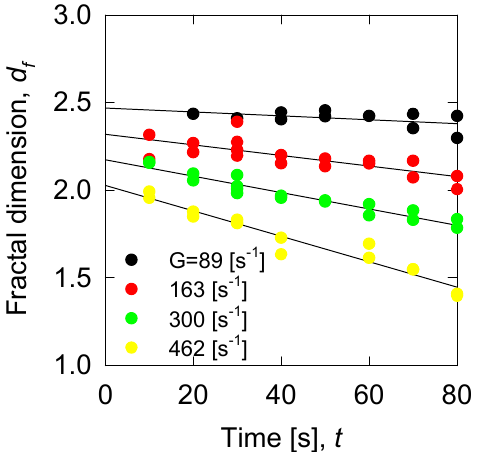
Figure 2. Temporal evolution of the fractal dimension during flocculation of synthetic tailing particles in seawater at pH 8 as a function of shear stress (G).